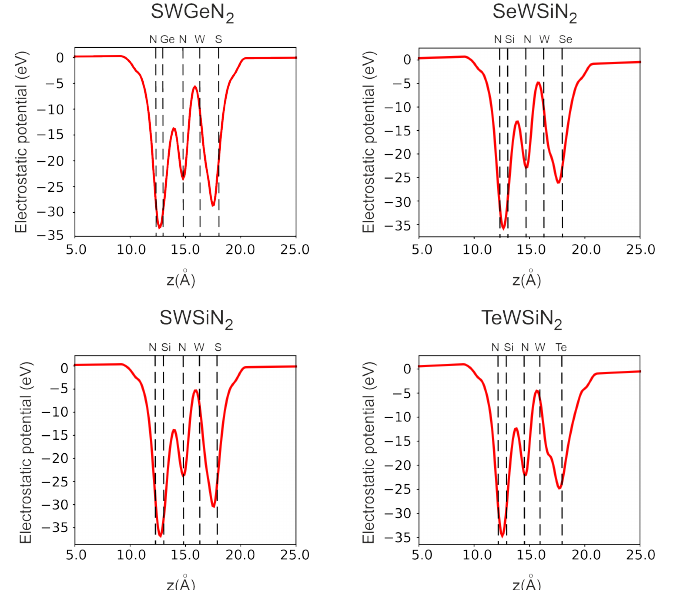
Figure 6. Electrostatic potential in X-W-AN 2 (X = S, Se, Te, A = Si, Ge). Dashed lines indicate the positions of atoms.